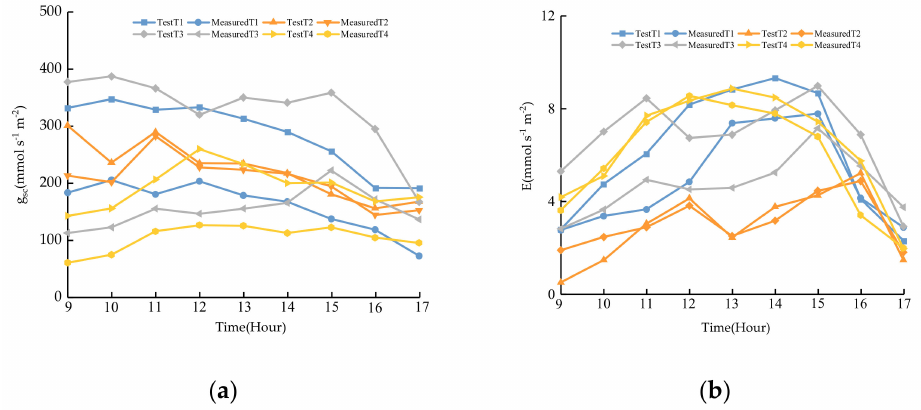
Figure 10. Changes of photosynthetic parameters of lettuce leaves in one day under different water treatments; ( a ) measured value and test value of E; ( b ) measured and experimental values of g sc